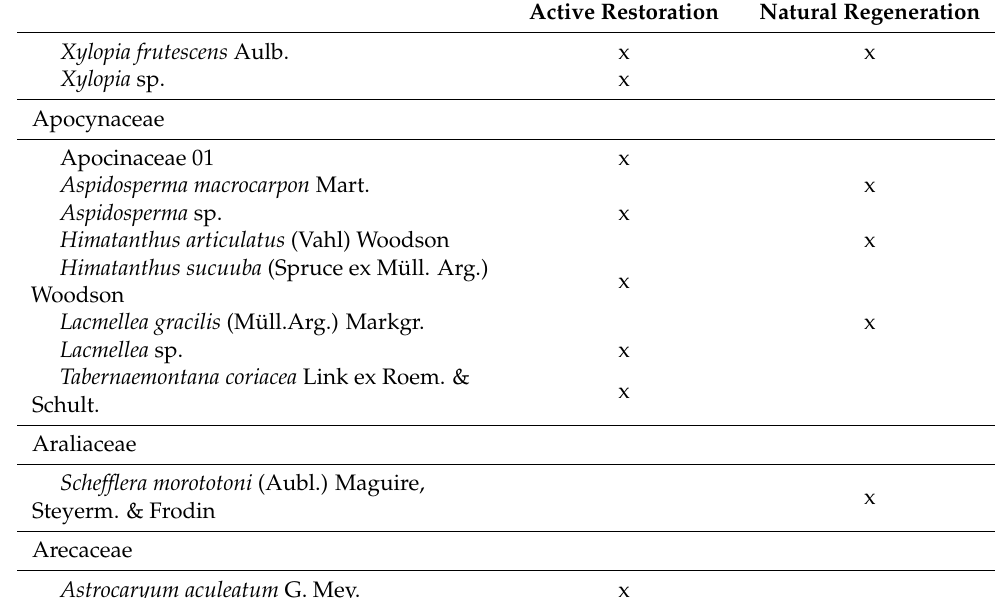
Table A2. Cont. Xylopia frutescens Aulb. x x Xylopia